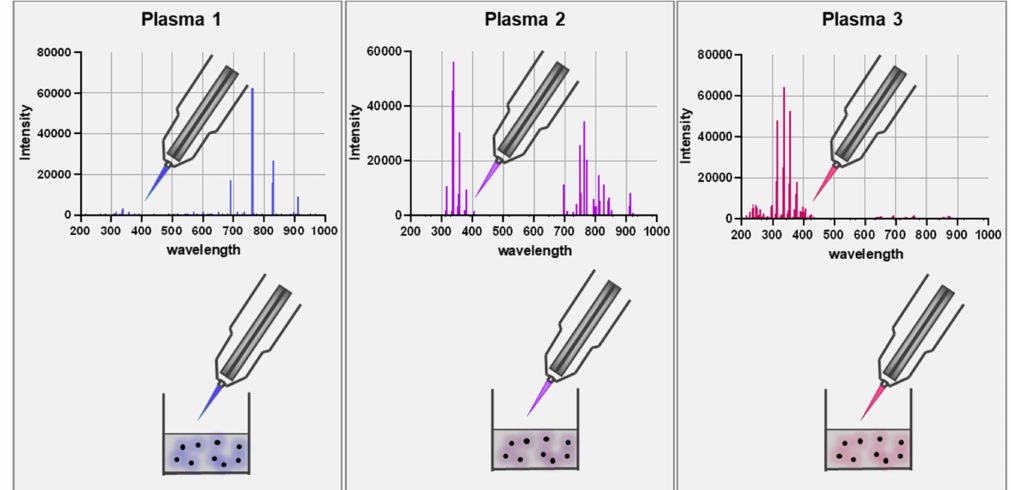
Figure 1. Scheme of using different feed gas settings to generate gas plasma with distinct ROS cocktail profiles. The upper panel represents optical emission spectroscopy (intensity: relative units; wavelength: nanometer) measurements of the visible plasma effluent leaving the jet device. The lower panel is a schematic of a biological target being exposed to the gas plasma resulting in distinct oxidative modification patterns as depicted with the color